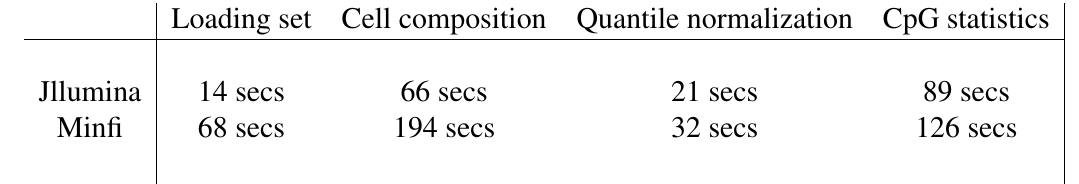
Table 1: Jllumina and Minfi R package run times. All steps were performed on a standard Mac- book Air with Intel core i5, 1 . 6 Ghz and 8GB of RAM. We used 1000 permutations for Jllumina’s CpG